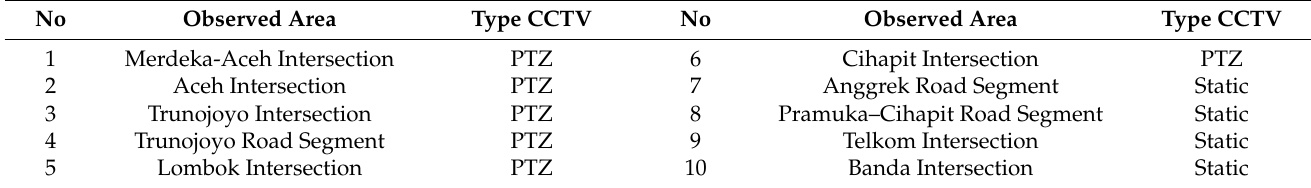
Figure 13. Observation area. Table 6. Several covered roads using